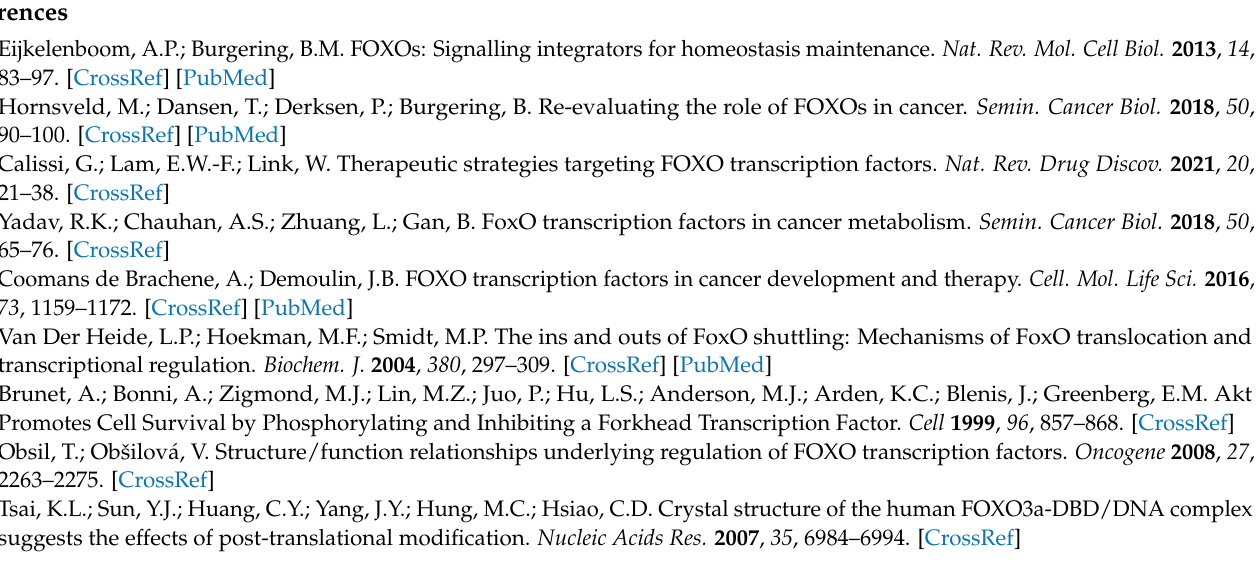
of FOX03, Figure S2: Starting model of FOXO3 bound to DNA, Figure S3: Gaussian kernel density estimation of the phase space determined by root mean square (RMSD) and solvent accessible surface area measurements from the ten independent implicit simulations over 500 ns simulation time. Figure S4: Frequency of secondary structure elements across ten independent molecular